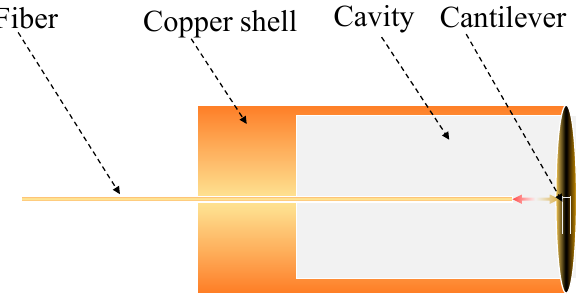
Figure 1. The schematic diagram of the FOM design, based on the FPI structure.